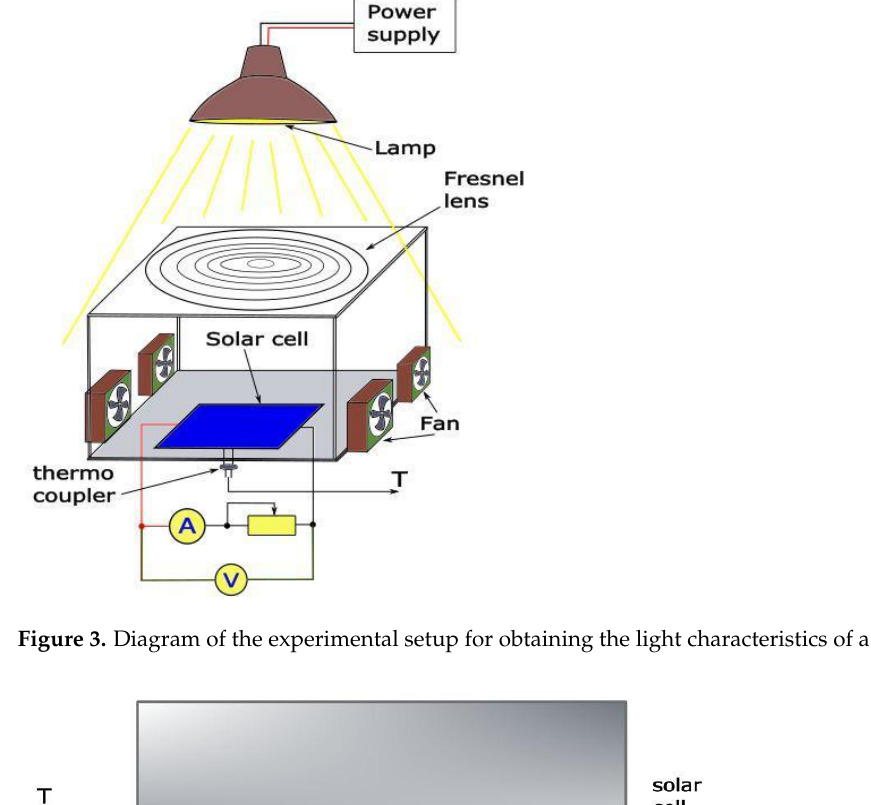
Figure 3. Diagram of the experimental setup for obtaining the light characteristics of a solar cell.